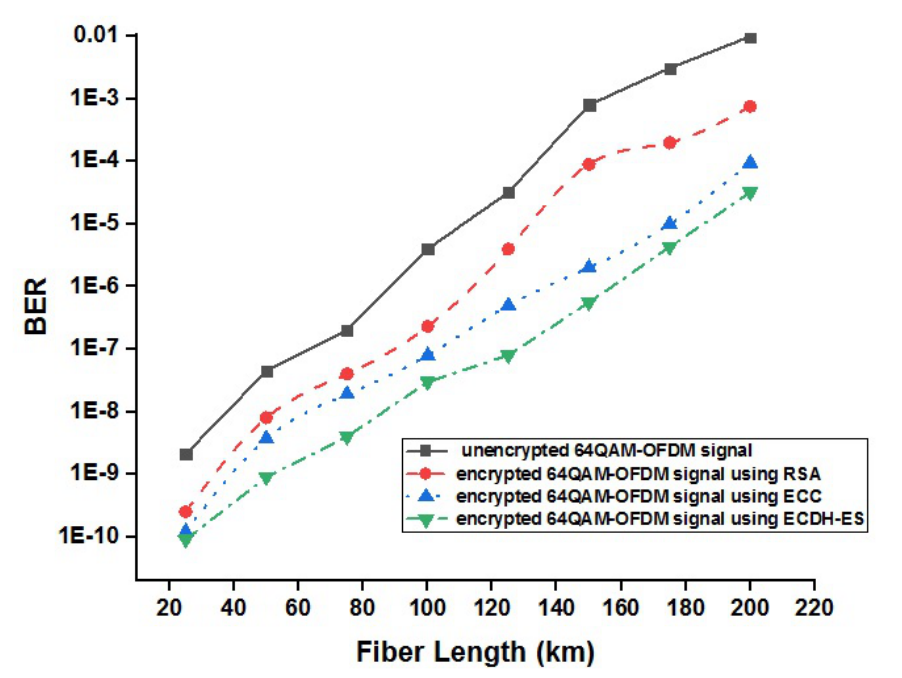
Figure 5. Comparison of ECC, RSA, and ECDH-ES algorithms used for enlarging quality of physical layer security of matured